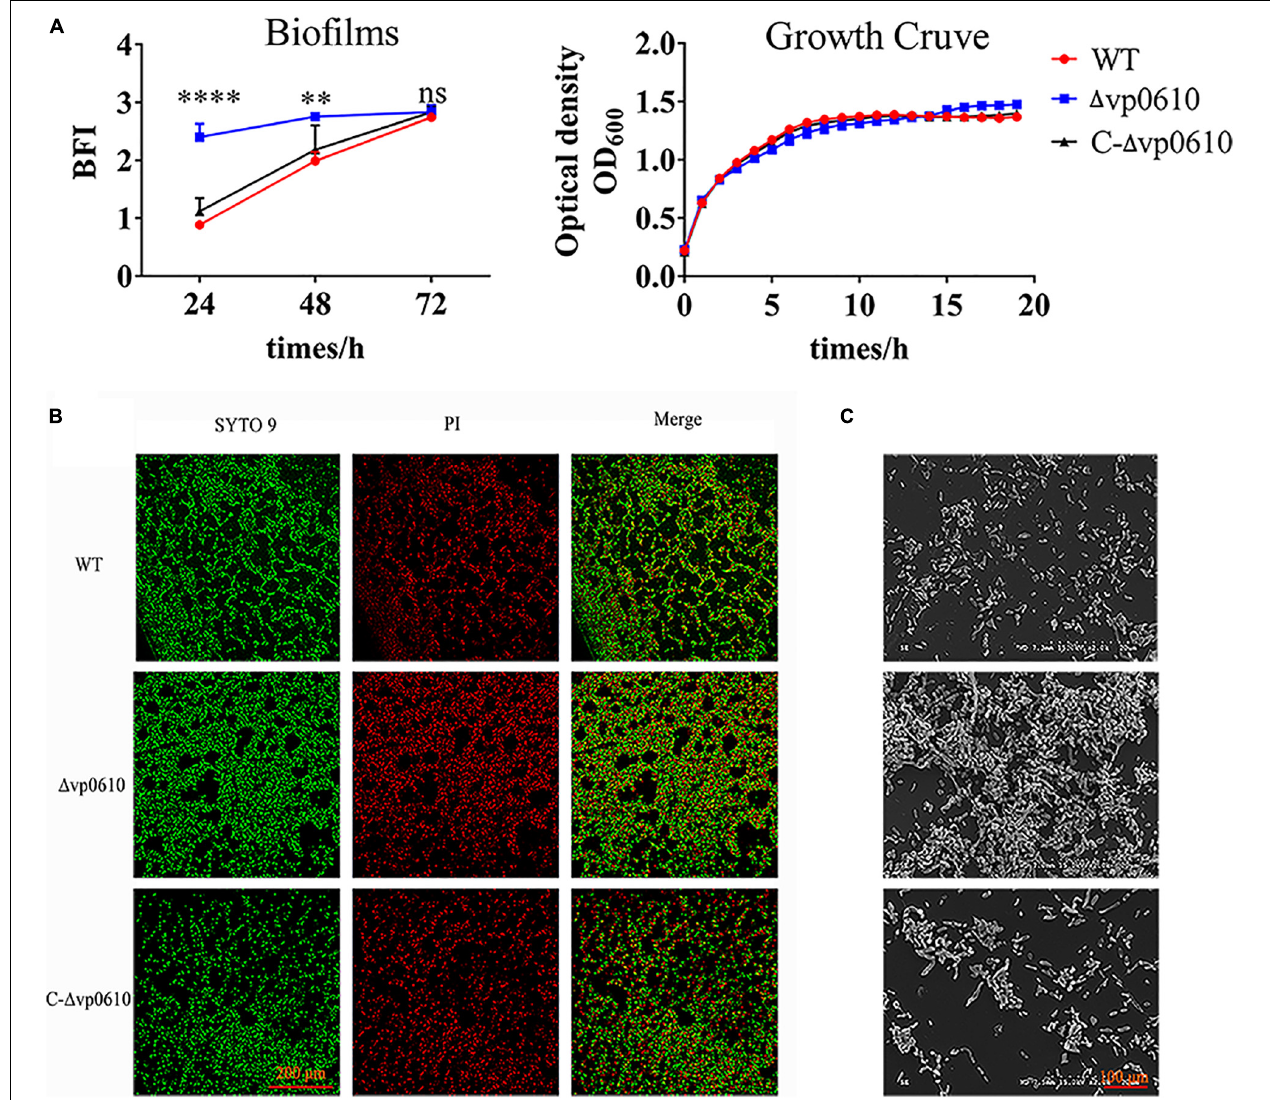
FIGURE 2 | VP0610 inhibits biofilm formation in the initial stage. (A) Biofilm formation was determined at different times using a crystal violet staining method (Heo et al., 2019); growth curves were measured at 600 nm for 24 h. (B) Biofilm formation was visualized using confocal laser scanning microscopy. (C) Biofilm formation was visualized using scanning electron microscope. Significance was calculated by analysis of variance and Dunnett’s test comparison for differences from biofilm formation. ** p < 0.01; **** p < 0.0001; ns, non-significant.